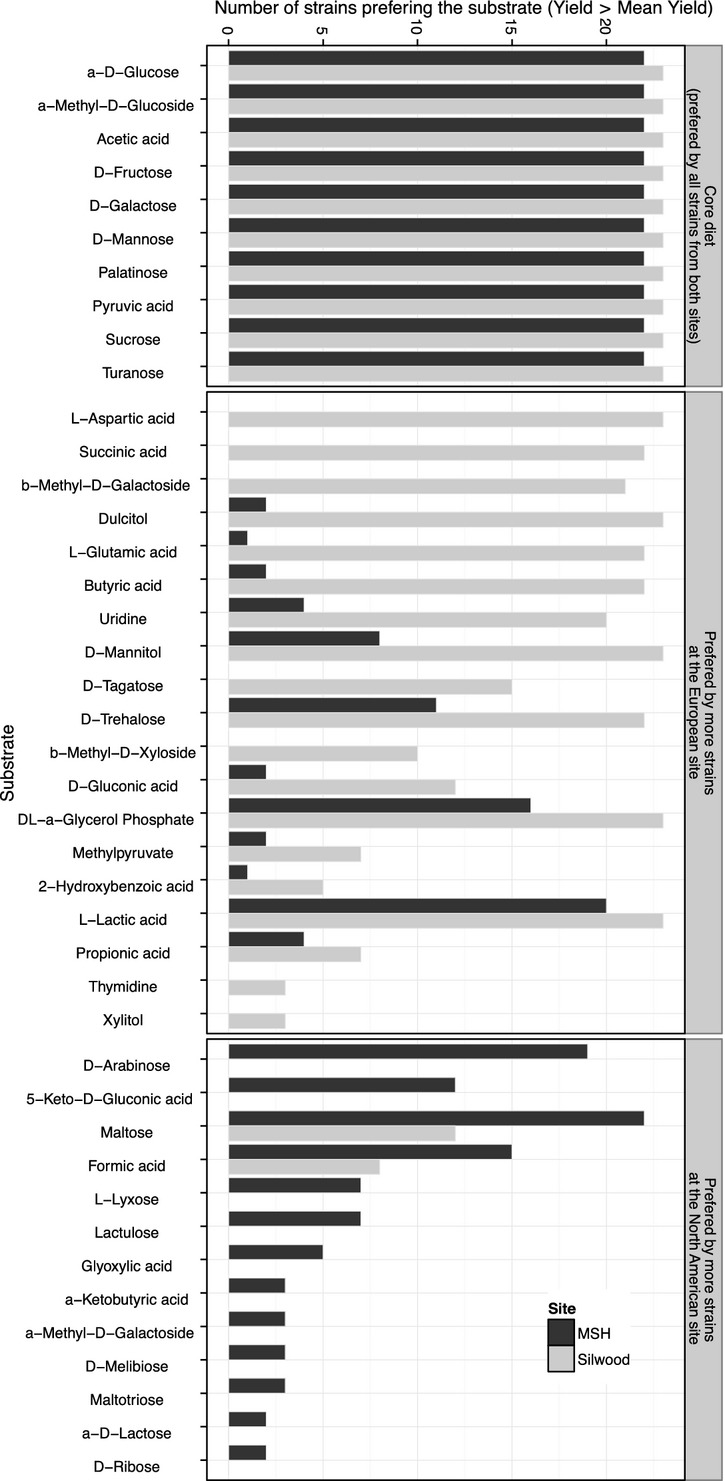
Number of isolates from MSH (black) and Silwood (gray) preferring given substrates. The criterion for preference is that the yield deviation from mean yield across all substrates is positive, that is, yield on target substrate > mean yield across substrates. Substrates in the core diet are preferred by all isolates from both locations. Substrates from the ancillary diet that differ in preference between sites are grouped according to the site with most isolates preferring the substrate and ordered by the difference in isolate preference between sites.